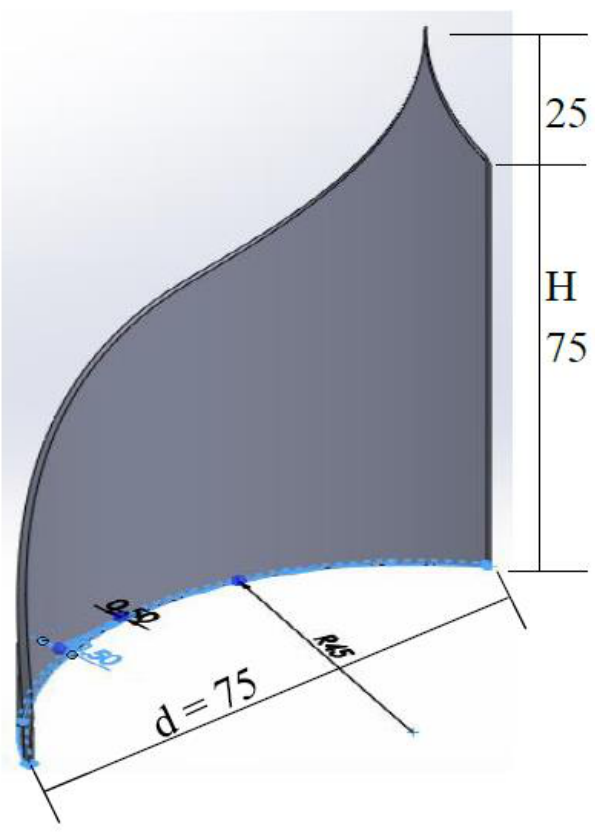
Figure 4. IceWind blade (dimensions are in mm).